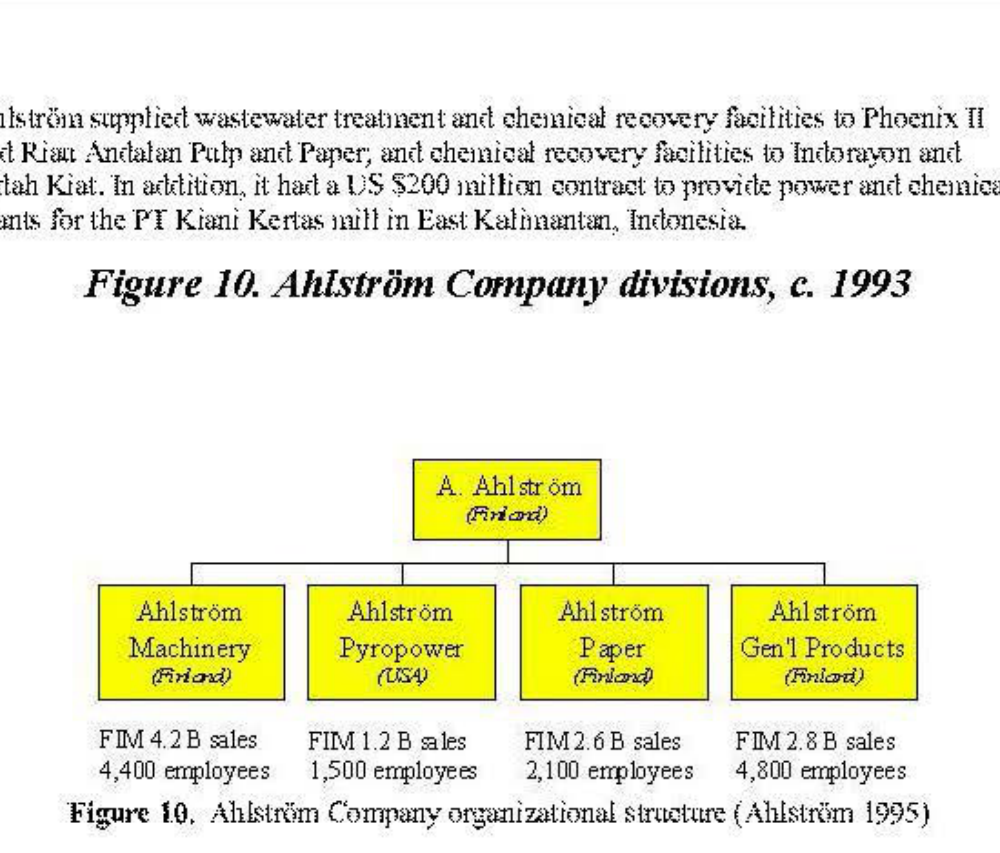
Figure lO. Ahlstnim Company organizational structure ( Ahlstnim